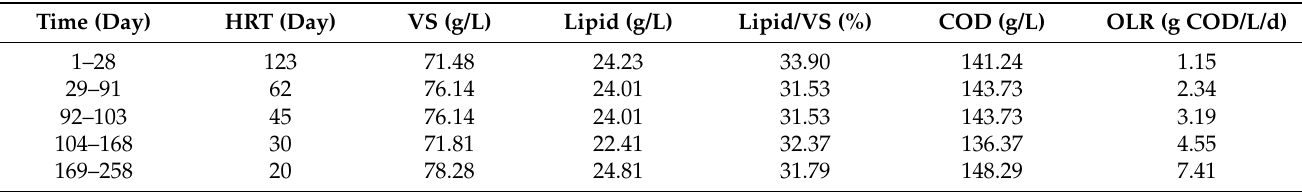
Table 1. Substrate characteristics and operational conditions for three